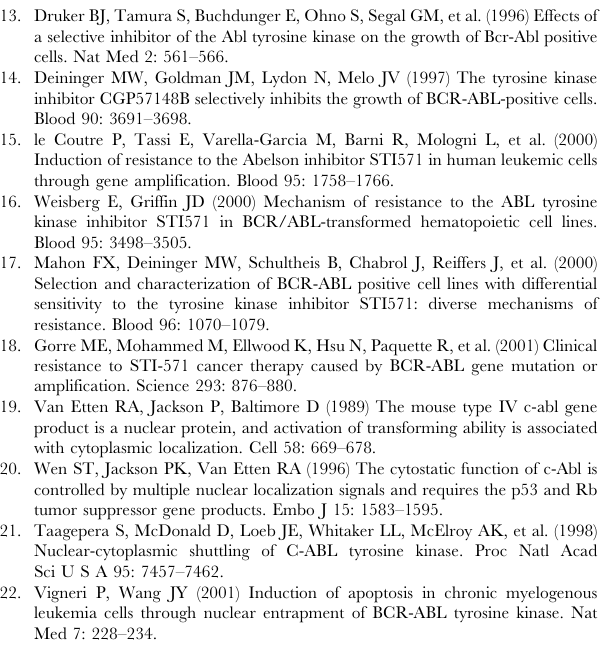
(see nuclei marked by arrows). Nuclei were counterstained with Hoechst dye (blue). (TIF) Figure S4 Imatinib binding re-activates the NLS func- tion in kinase-defective BCR63-ABL with phenylalanine substitution at tyrosine 232, 253, 257. The indicated constructs (KD: kinase-defective) were transfected into COS cells and the cells treated with LMB alone or LMB plus imatinib as indicated. Subcellular localization of the transiently transfected proteins was determined by indirect immunofluorescence staining with anti-ABL (8E9) antibody (red). DNA is counterstained with Hoechst dye (blue). Nuclear accumulation of the indicated kinase- defective BCR 63 -ABL-Y/F mutant protein was marked by white arrows. (TIF) Figure S5 BCR63-ABL- D 1121 does not co-localize with actin fibers. The BCR63-ABL- D 1121 protein was transiently expressed in COS cells. Immunofluorescence images of anti-ABL (8E9) staining (red) and F-actin stained with Alexa-488-conjugated phalloidin (green) are shown individually as well as merged (right most panel) with DNA staining by Hoechst dye (blue).